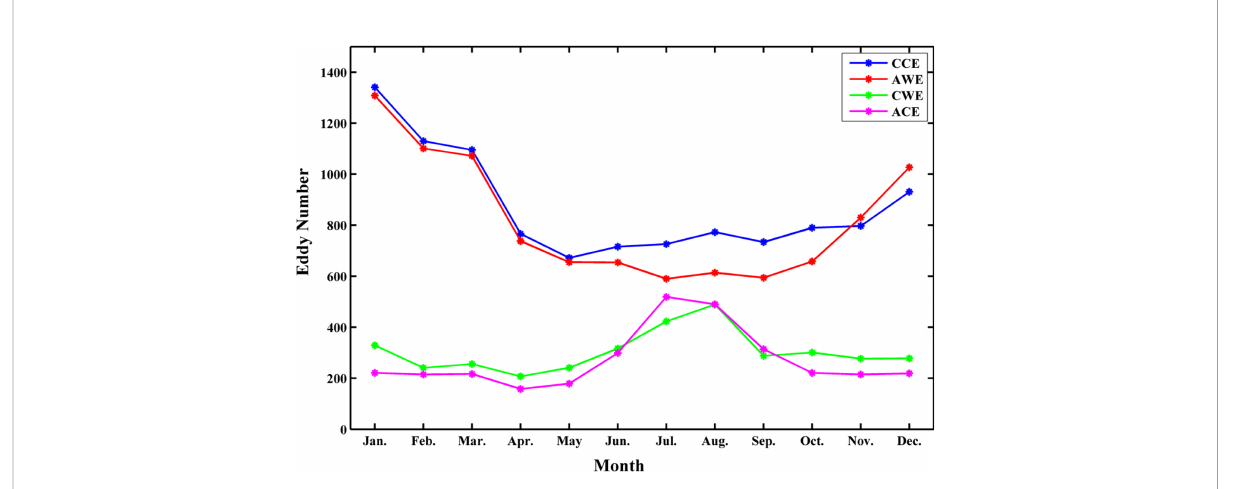
FIGURE 8 Seasonal distribution of the four types of eddy numbers. The blue, red, green, and magenta lines represent cyclonic cold-core, anticyclonic warm-core, cyclonic warm-core, and anticyclonic cold-core eddies,